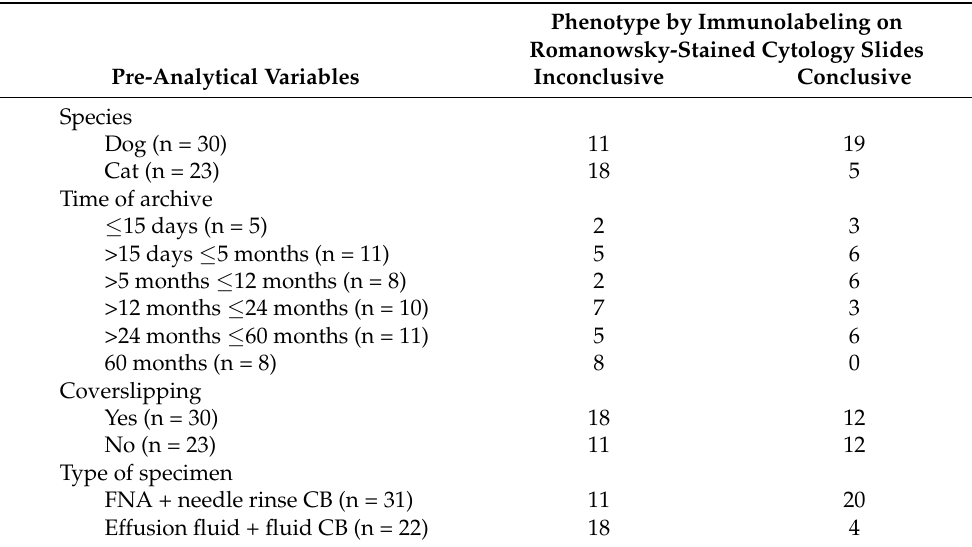
Table 5. Pre-analytical characteristics of cases with inconclusive and conclusive immunophenotyping diagnosed by immunolabeling on 53 previous Romanowsky-stained cytology